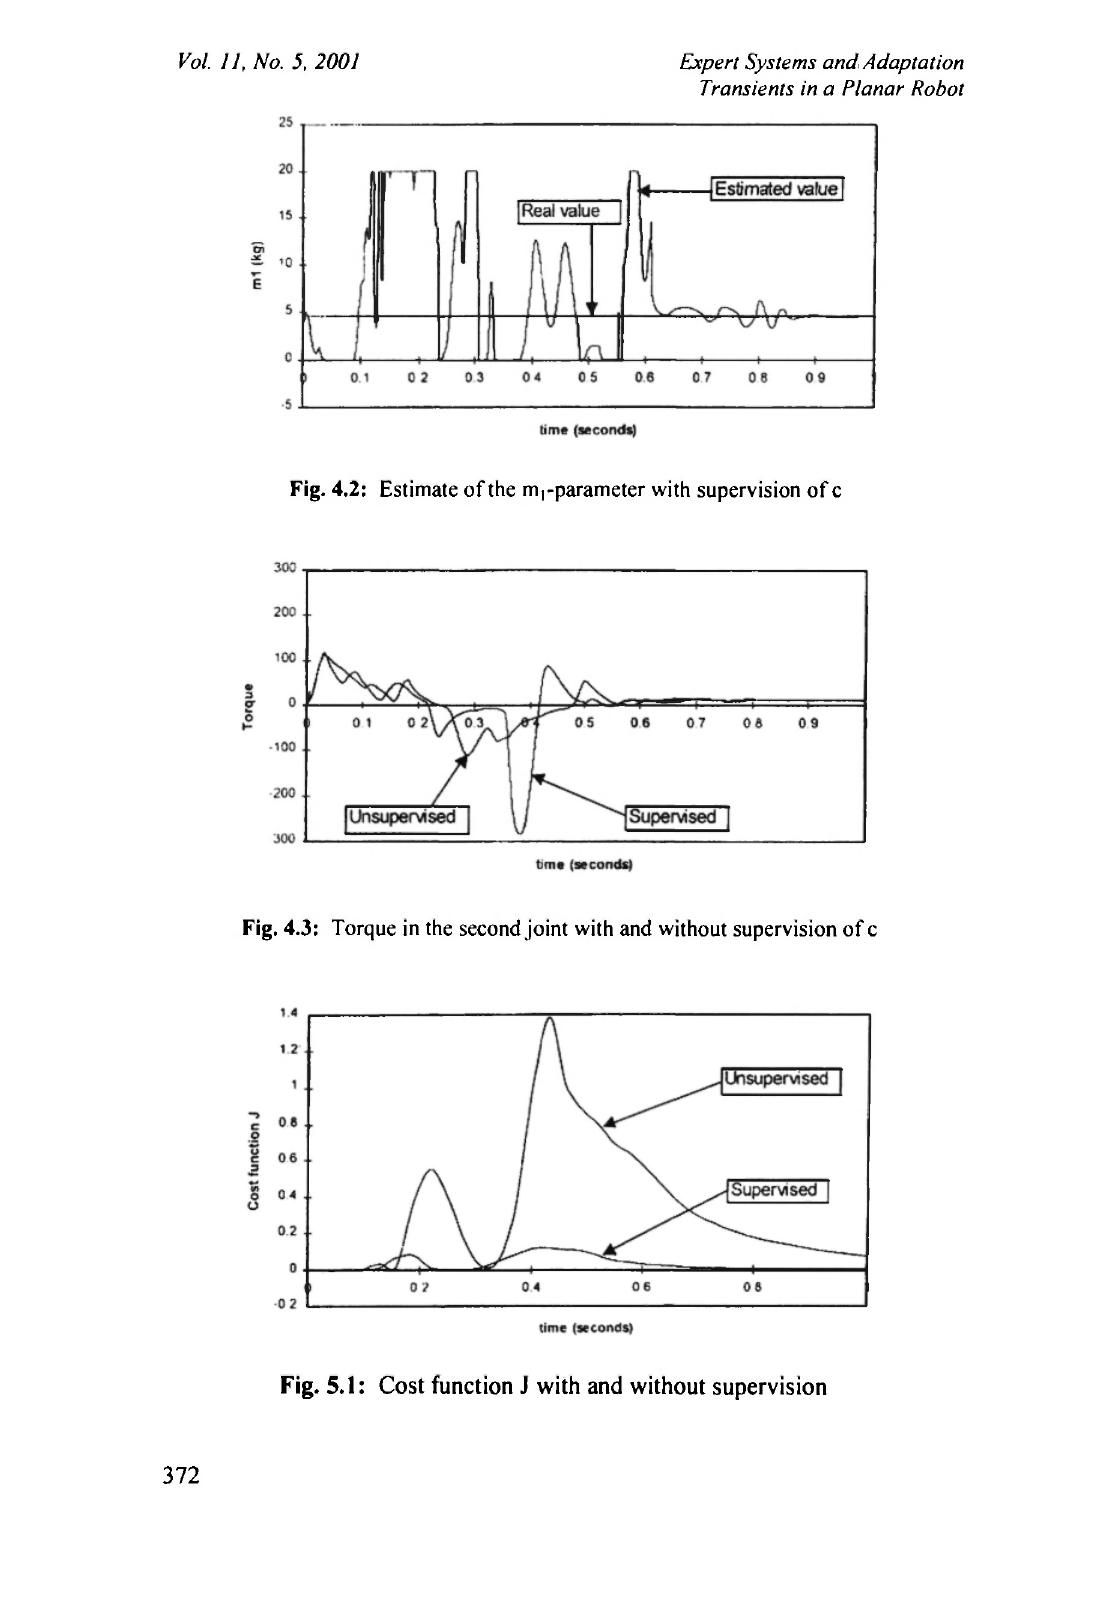
Fig. 4 .2: Estimate of the m r parameter with supervision of c